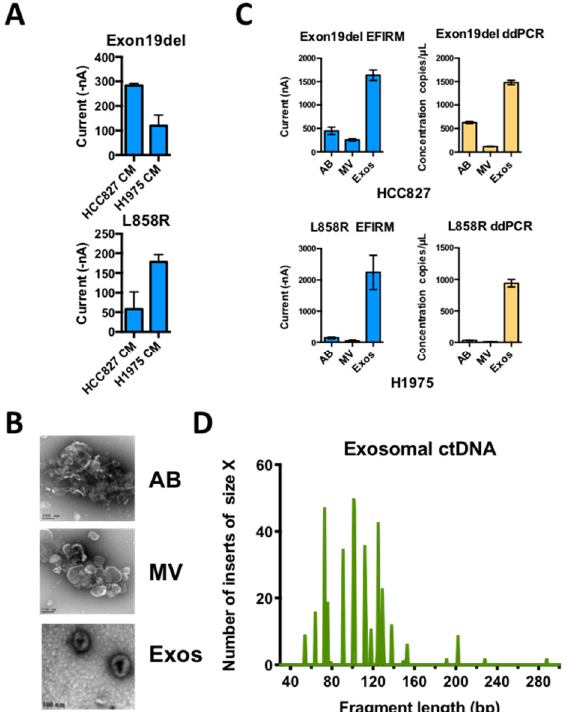
Figure 5. Distribution of usctDNA with mutated EGFR DNA in di ff erent extracellular vesicles from conditioned cell culture media. ( A ) Direct detection of EGFR mutations in conditioned media from H1975 and HCC827 cell culture with EFIRM assays. Apoptotic bodies (AB), microvesicles (MV), and exosomes (Exos) were isolated from conditioned media (CM) with di ff erential ultracentrifugation method. Characterization of the vesicles by TEM ( B ). The distribution of EGFR L858R and exon 19-del ctDNA in di ff erent fractions of EVs from H1975 ( C , lower panel) and HCC827 ( C , upper panel) cell culture media was tested with EFIRM and ddPCR assays. The ctDNA extracted from exosome fraction was further used to generate a single-stranded DNA library. High-resolution size analysis for ctDNA harboring L858R in exosomal ctDNA was shown in ( D ).